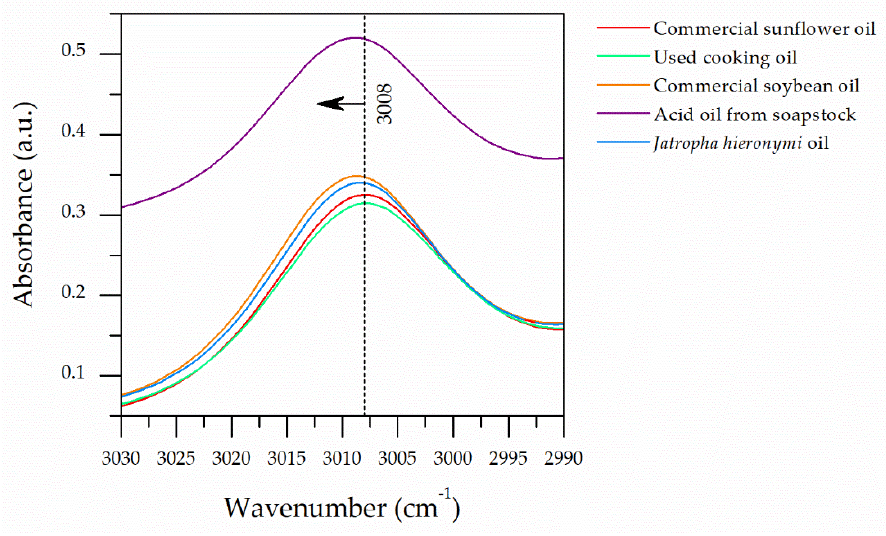
Figure 4. FT-IR spectra in the 2990–3030 cm − 1 region. Table 2. Results of the catalytic performance of the Na / SBA-15 (10) R8 with the studied raw materials. Feedstock